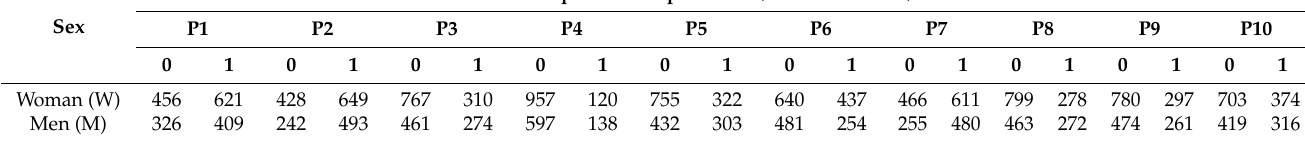
Table 3. The principles of prosumption that were not selected (symbol 0) and selected (symbol 1) by the respondents divided by sex. Table of Observed Frequencies. Input Table (Row × Column): 27 × 27 Burt Table